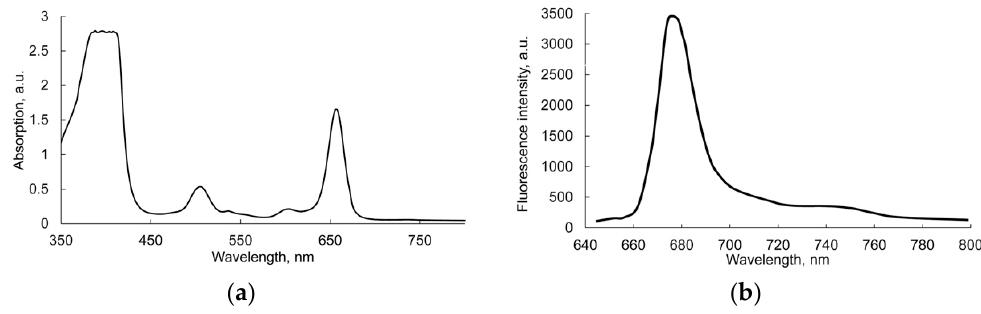
Figure 2. Absorption ( a ) and fluorescence ( b ) spectra of Fotoditazin ® .